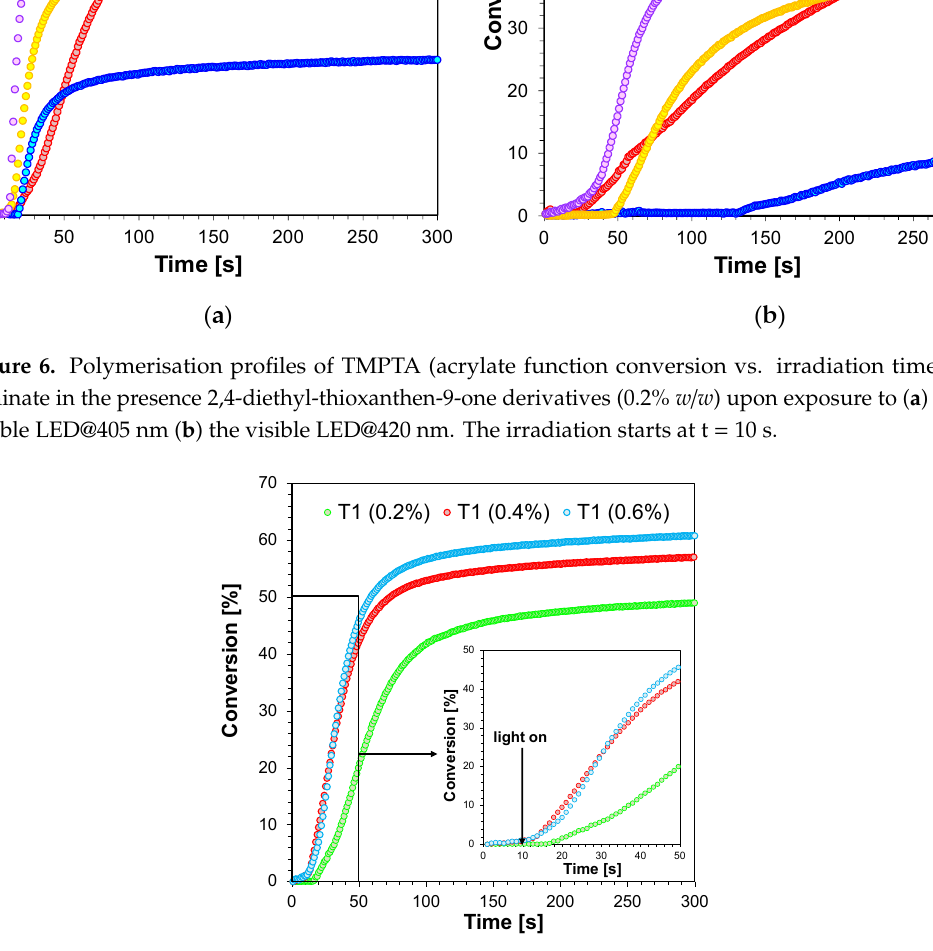
Figure 7. Polymerisation profiles of TMPTA (acrylate function conversion vs. irradiation time) upon exposure to the visible LED@405 nm in laminate in the presence of 2,4-diethyl-7-[4-( N -phenylanilino)phenyl]thioxanthen-9-one (T1) (0.2%, 0.4% and 0.6% w / w ). The irradiation starts at t = 10 s.